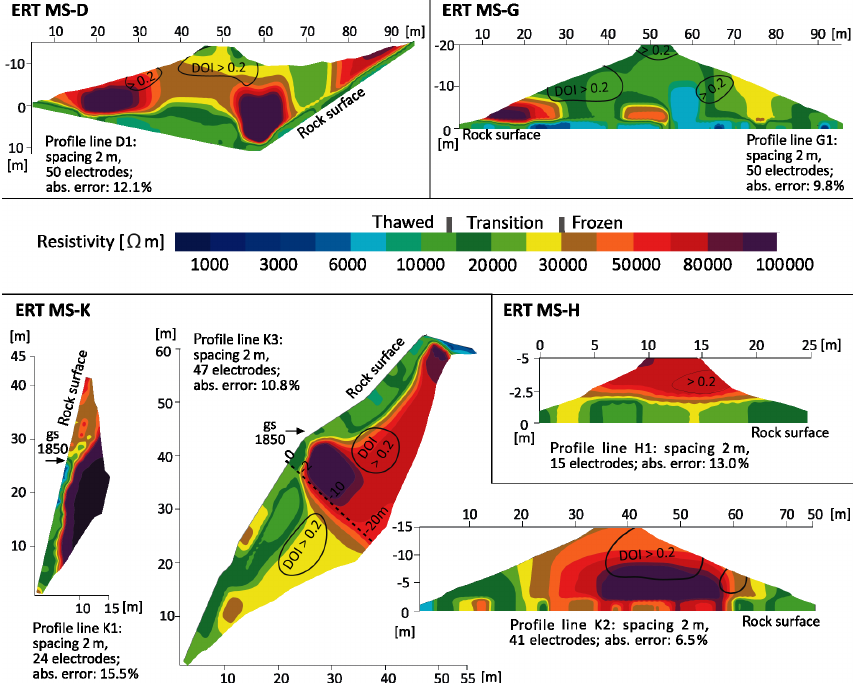
Figure 6. ERT results at MS-D (measurement site Dirndln), MS-G (Gjaidstein), MS-K (Koppenkarstein) and MS-H (Hunerkogel). Abbrevi- ation: gs 1850, glacier surface at ca. 1850.